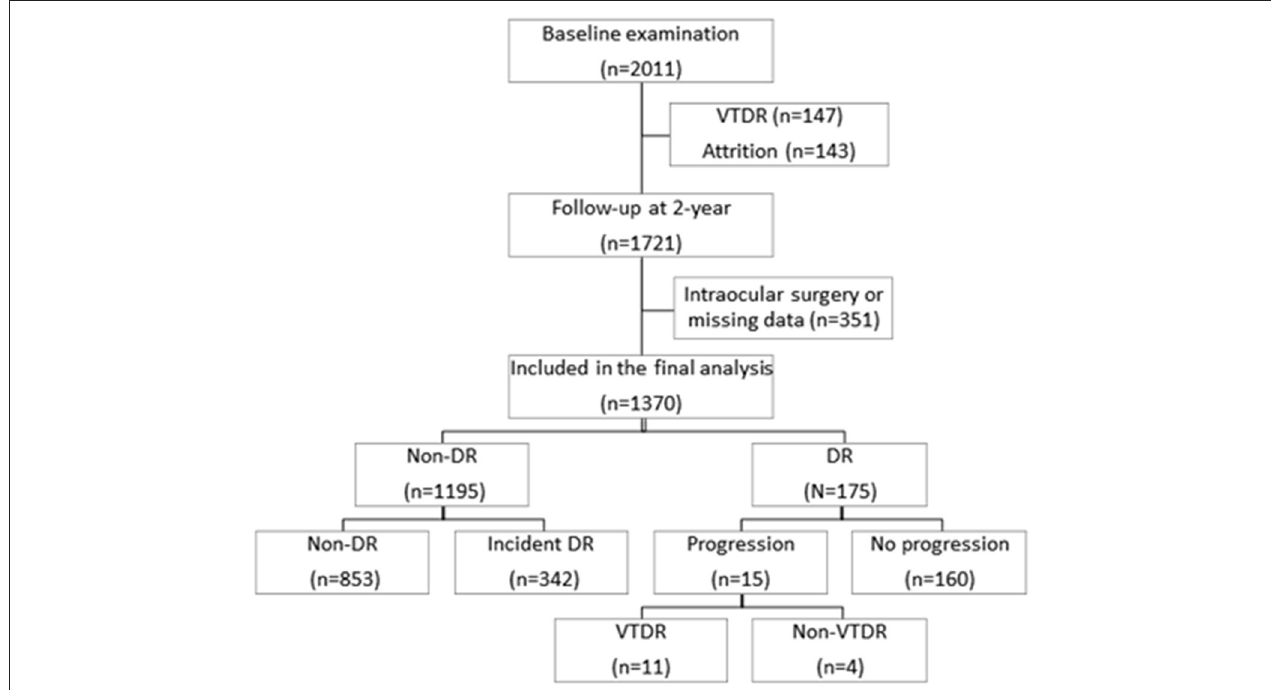
FIGURE 1 | Flowchart of the participants selection.